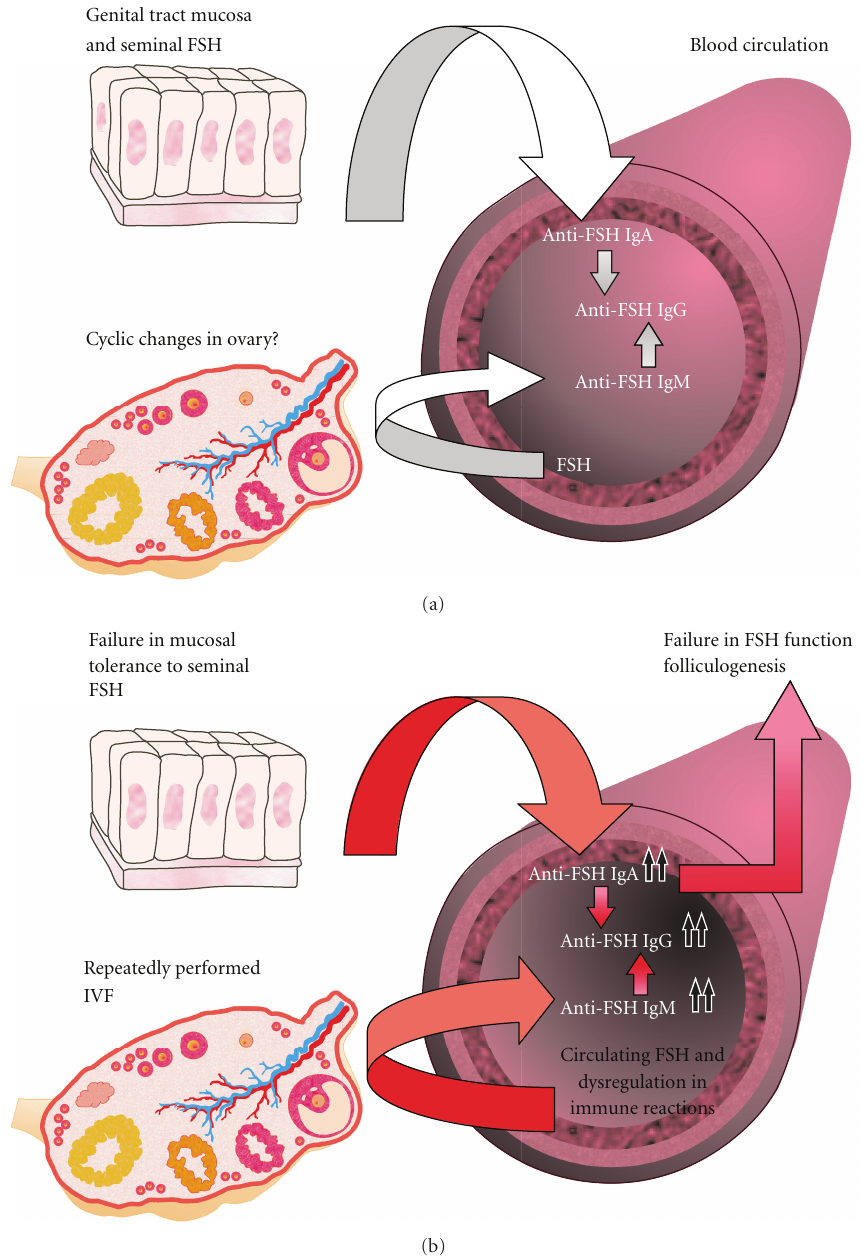
Figure 1: (a) Schematic overview of anti-FSH antibodies in healthy female. Antibodies detected against FSH could be natural antibodies also subjected to pregnancy-associated immune system regulations. Anti-FSH IgA detected in female circulation could be a part of the mucosal response involved in inducing immune tolerance to seminal constituents. Anti-FSH IgM associates with the peripheral level of FSH hormone and possibly contributes along with the mucosal-associated induction of IgA to the production of circulating anti-FSH IgG. (b) Increased production of naturally occurring anti-FSH antibodies in case of female infertility. The production of anti-FSH IgM and IgG antibodies could be related to a general propensity to autoimmunity or to previous IVF treatments. The elevated values of anti-FSH IgA could be explained by a genetically determined failure in mucosal tolerance in the genital tract. Anti-FSH IgG and IgA antibodies, present in sera, accumulate into the preovulatory follicle, where they a ff ect negatively oocyte